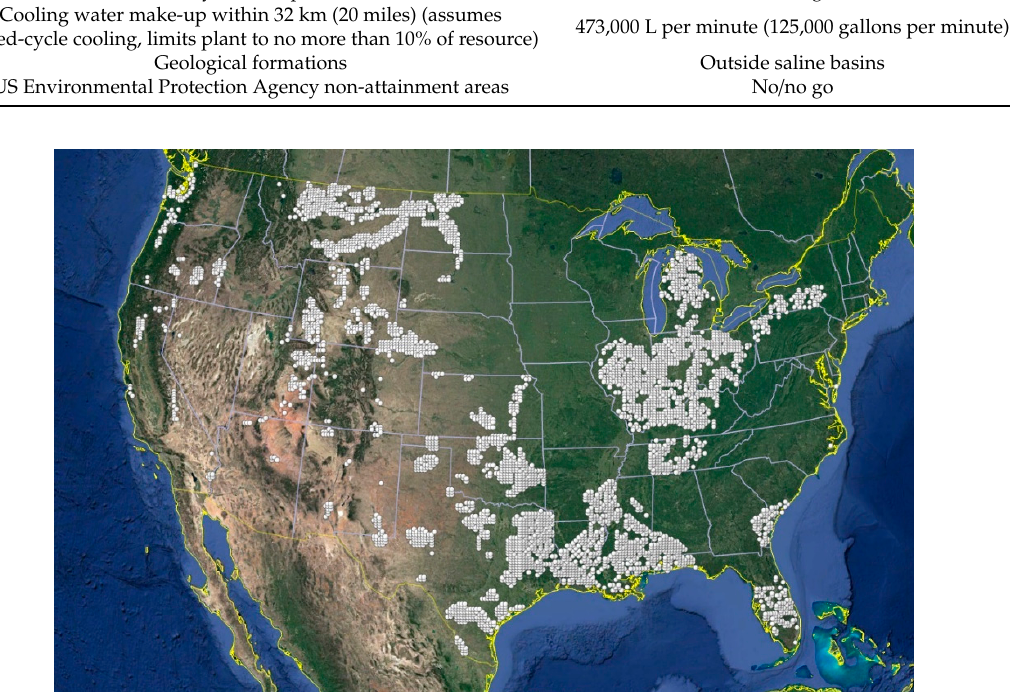
Figure 3. Geographic extent of potential areas suitable for BECCS using selection criteria shown in